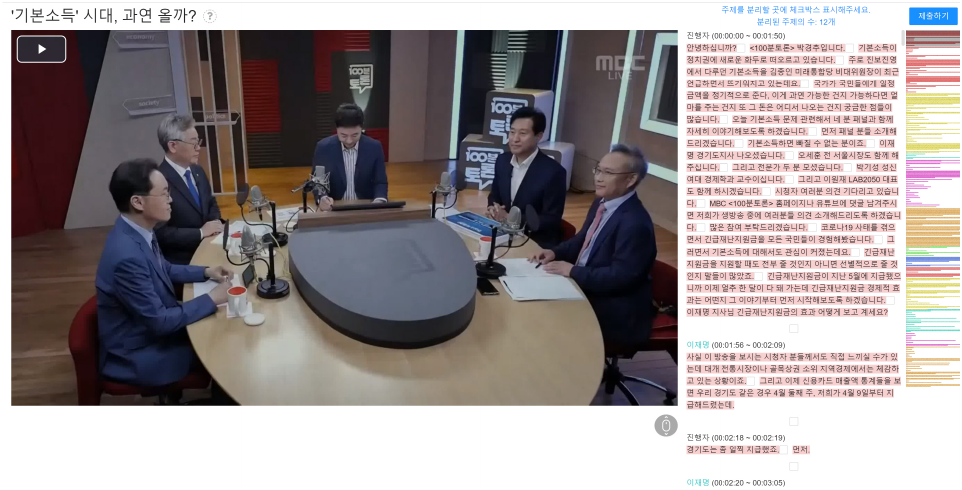
Figure 20. User interface configured to collect topic segmentation points from a subject.